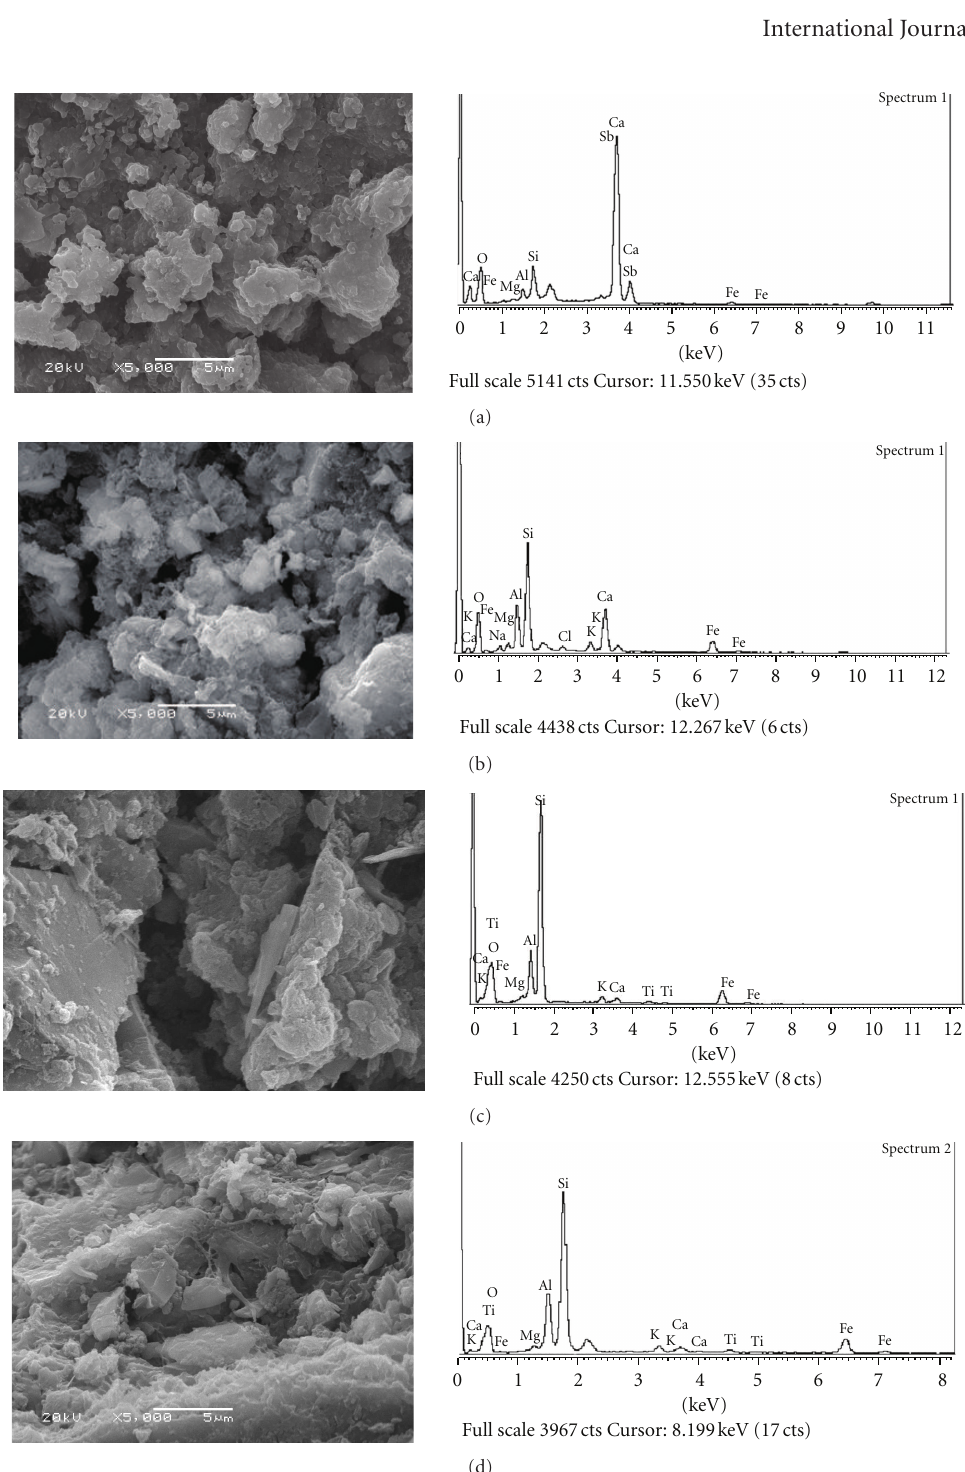
Figure 4: SEM micrograph ( × 5000) and EDS spectra for concrete attacked by acid ((a) controlled specimen; (b) specimen exposed to acid for 3 days; (c) specimen exposed to acid for 7 days; (d) specimen exposed to acid for 10